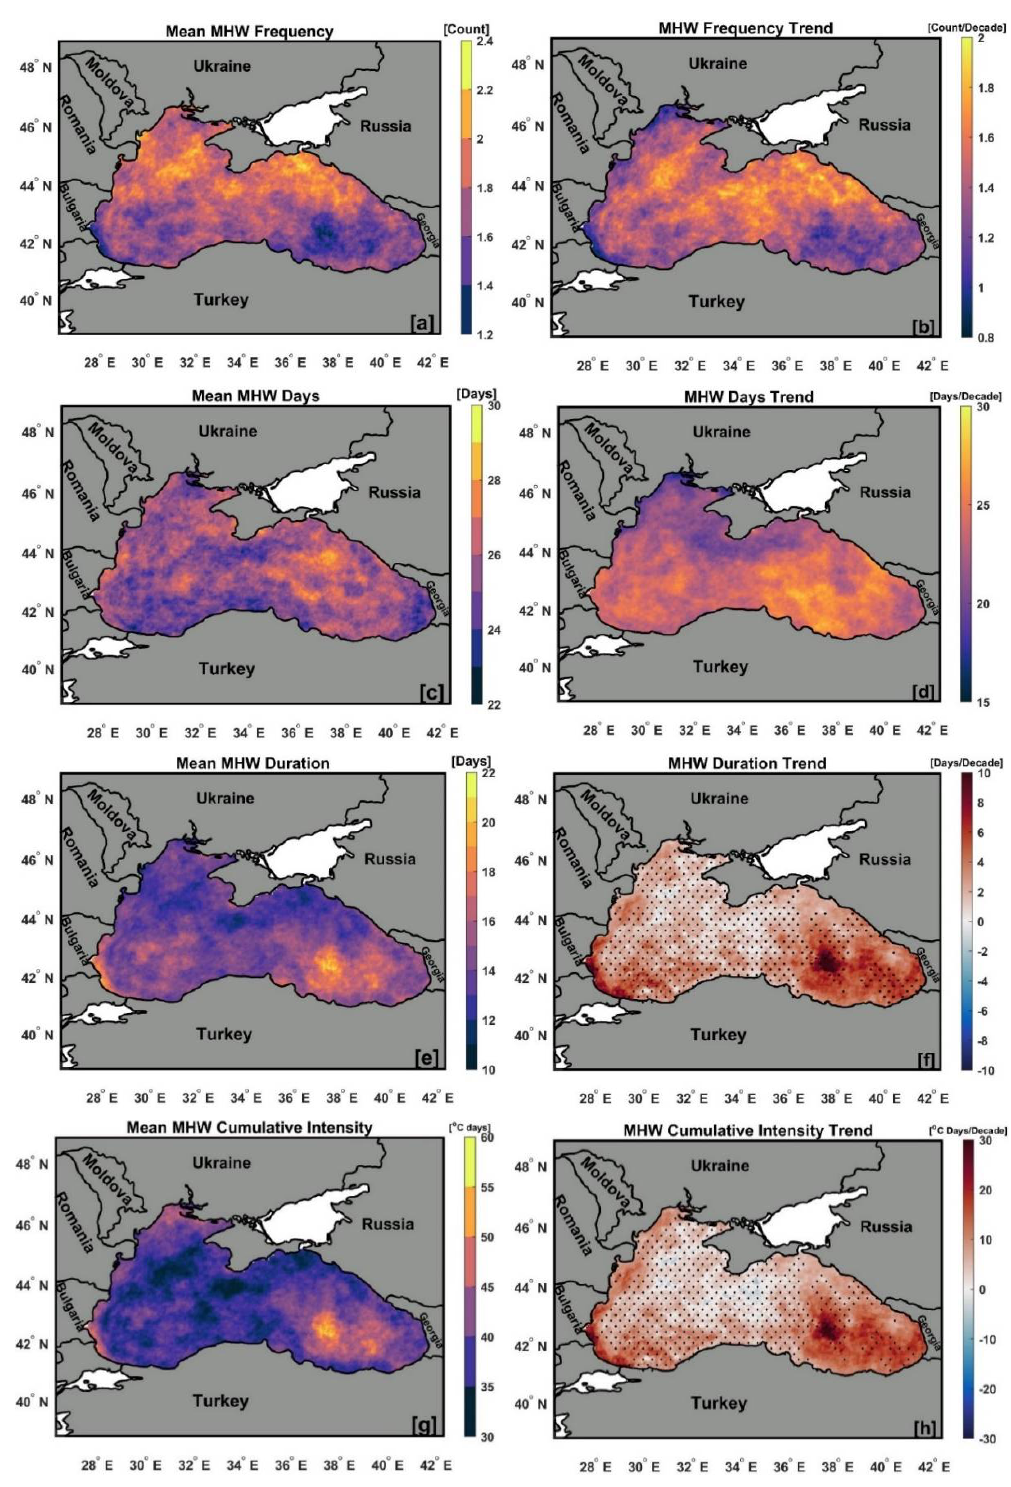
Figure 5. The annual means and trends of the main MHW characteristics in the Black Sea during (1982–2020). ( a ) Mean frequency (Count), ( b ) frequency trend (Count/Decade), ( c ) mean total days (Days), ( d ) days trend (Days/Decade), ( e ) duration (Days), ( f ) duration trend (Days/Decade), ( g ) cumulative intensity (°C Days), and ( h ) cumulative intensity trend (°C Days/Decade). The black dots indicate that the change is not significantly different ( p > 0.05).